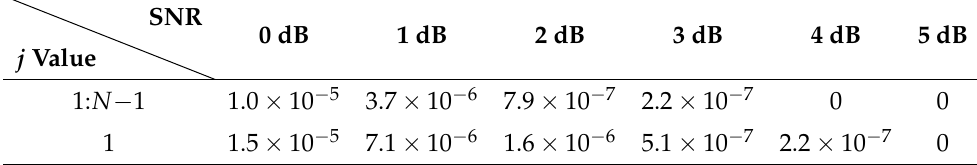
Table 5. Comparison of the false alarm rate between L 2 ( µ ) and L 3 ( µ ) .